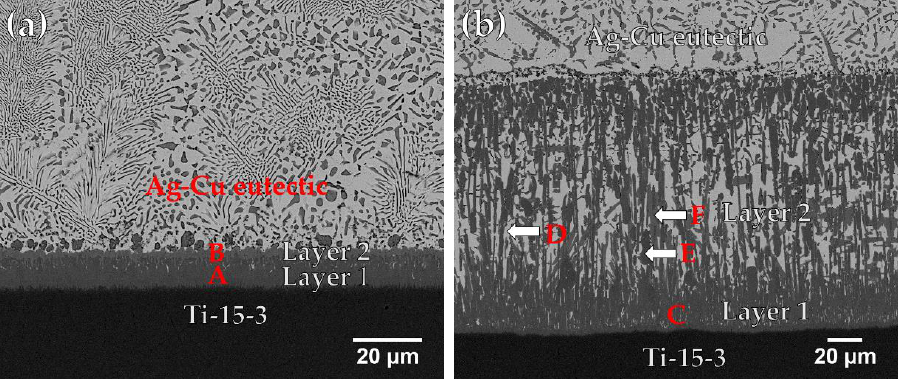
Figure 4. Cross-sectional observations of FESEM BEIs of Ti-15-3 substrate after wetting test using BAg-8 filler metal at ( a ) 800 and ( b ) 850 °C for 300 s.